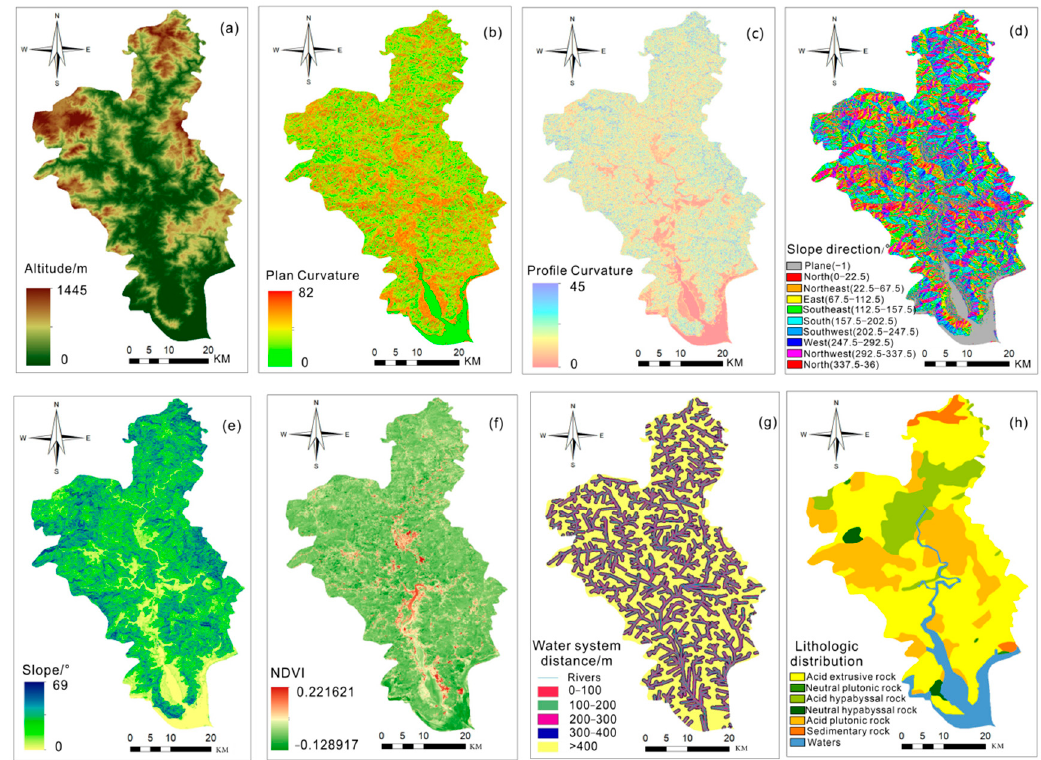
Figure 2. Environmental factors of landslides in Fu’an. ( a ) Elevation map. ( b ) Plane curvature map. ( c ) Profile curvature map. ( d ) Slope direction map. ( e ) Slope map. ( f ) NDVI map. ( g ) Water system distance map. ( h ) Lithology map.